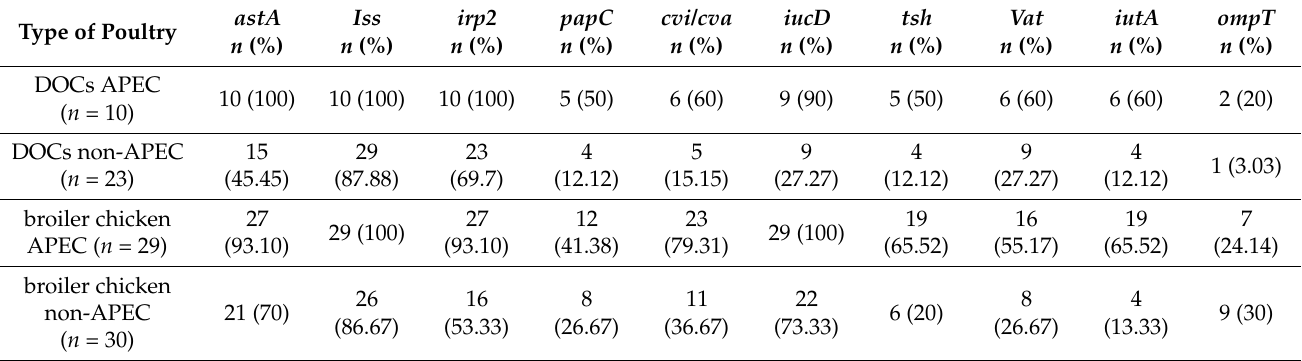
Table 2. Percentage of virulence genes in tested E. coli APEC and non-APEC